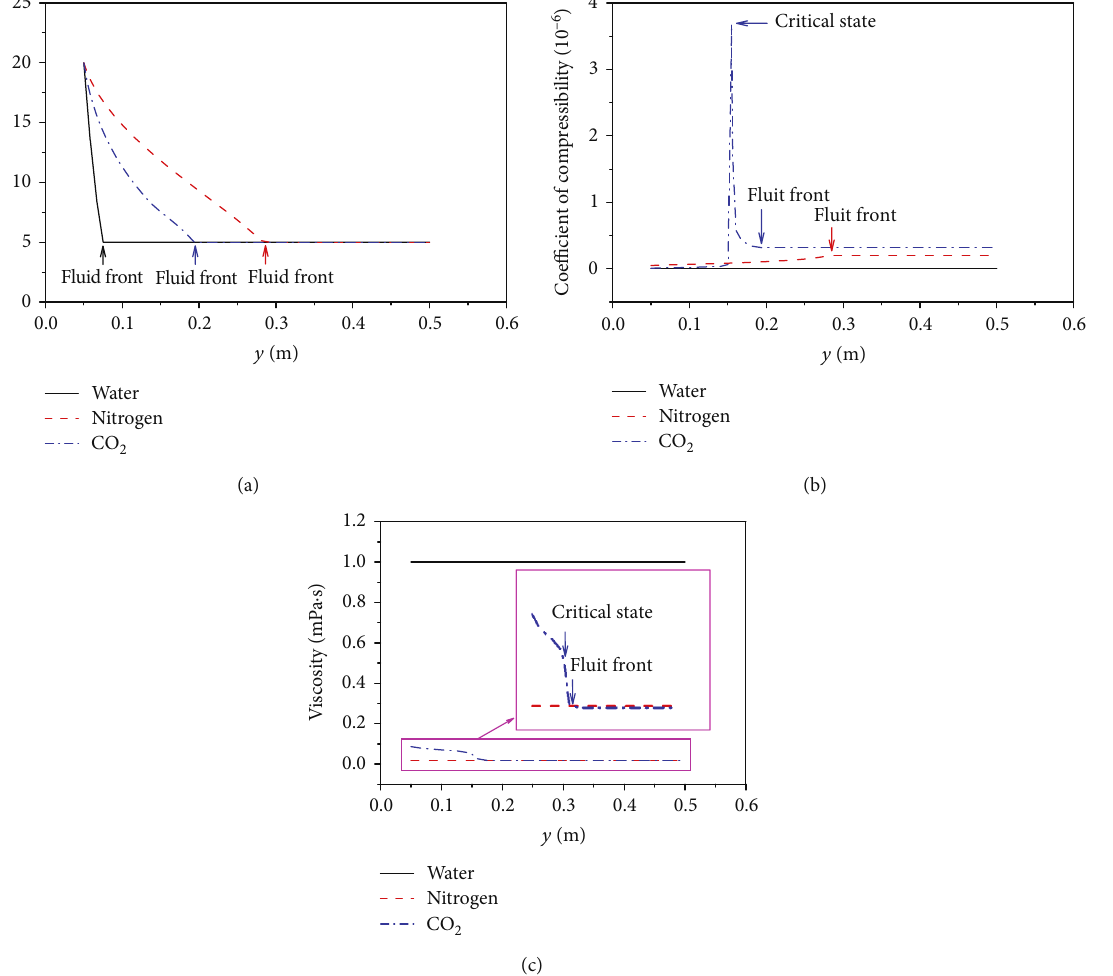
Figure 5: Changes of pore pressure and the coe ffi cient of compressibility and viscosity along the y direction during water and gas